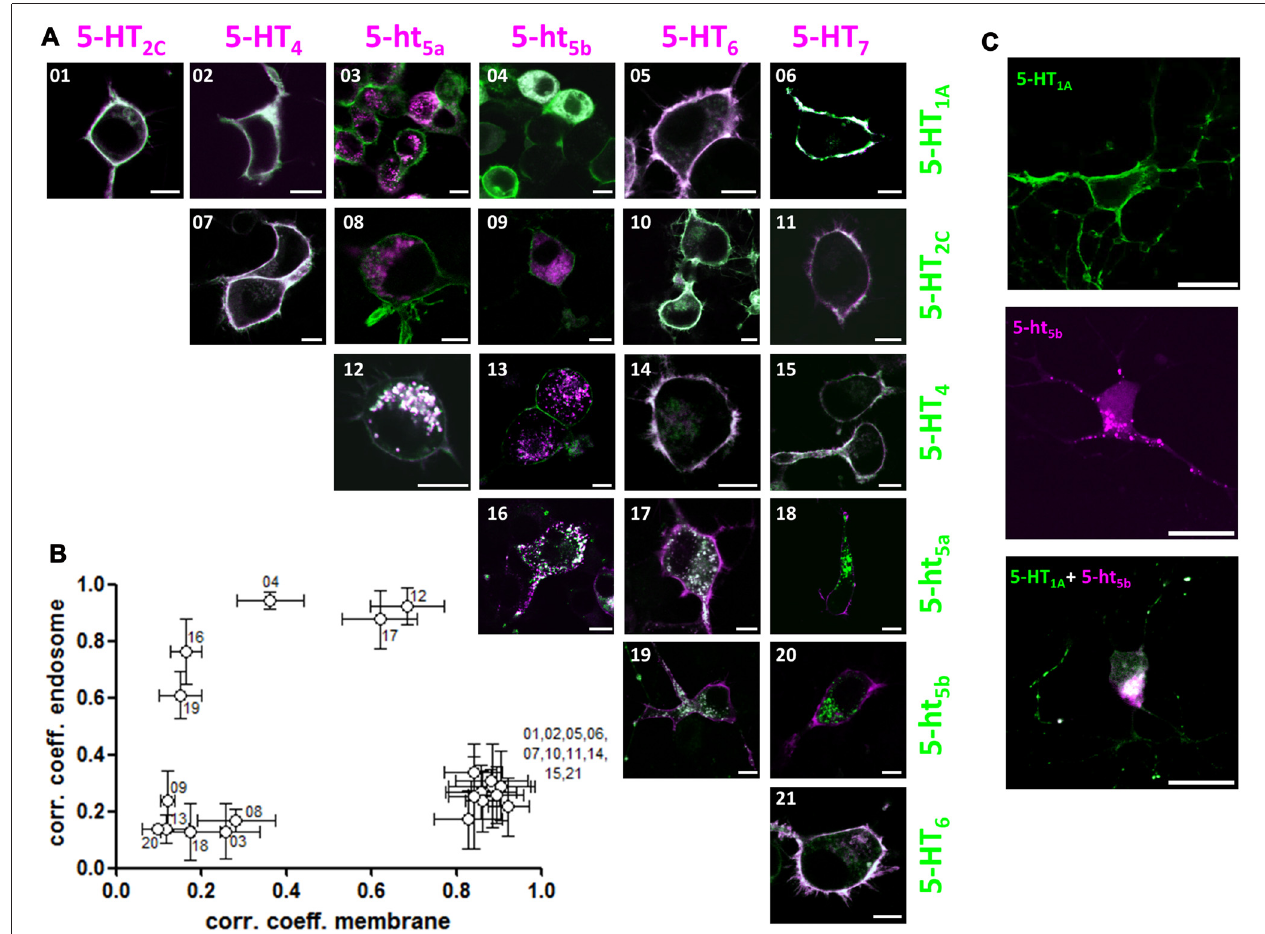
FIGURE 3 | 5-ht 5b specifically interacts with 5-HT 1A to change the latter’s subcellular localization. (A) We transfected a representative member of each 5-HT receptor subgroup tagged with mCherry against the same set of 5-HT receptors tagged with GFP. Each image of the matrix shows N1E-115 cells co-expressing two 5-HT receptors. The images are pseudo-colored purple for the receptor indicated horizontally and pseudo-colored green for the receptor indicated vertically. Co-localization is shown in yellow. 5-ht 5b specifically interacts with 5-HT 1A (04) with the normally strictly membrane-bound 5-HT 1A receptors partly retained intracellularly. In addition, 5-ht 5a seems to interact with 5-HT 4 (12) and 5-HT 6 seems to weakly interact with 5-ht 5a (17) and 5-ht 5b (19), although 5-HT 6 ’s surface expression remains strong. No other 5-HT receptors seem to interact with each other in a way that changes subcellular localization. Scale bars in all images are 10 µ m. (B) For quantification, we separately calculated Pearson’s correlation coefficients for the fluorescence signals at the membrane and at intracellular organelles by manually applying regions of interest (ROI). Plotting the organelle correlation coefficient over the membrane correlation coefficient for each receptor pair resulted in three populations of receptors. One population displays a high correlation at the membrane, but not at intracellular organelles. The second population displays correlation in neither compartment while the third population displays high correlation at intracellular compartments. (C) To verify interaction of 5-HT 1A and 5-ht 5b , we transfected primary hippocampal neurons with expression constructs of both receptors. 5-HT 1A (green) localizes to the cell membrane, while 5-ht 5b (purple) localizes to intracellular organelles, while co-expression of both receptors shows intracellular co-localization with no discernable membrane staining by 5-HT 1A . Scale bars in all images are 20 µ